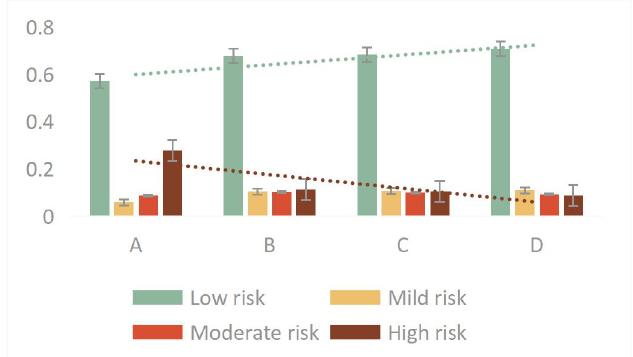
Figure 13 . Comparison of vulnerable areas under four grades of annual rainfall.